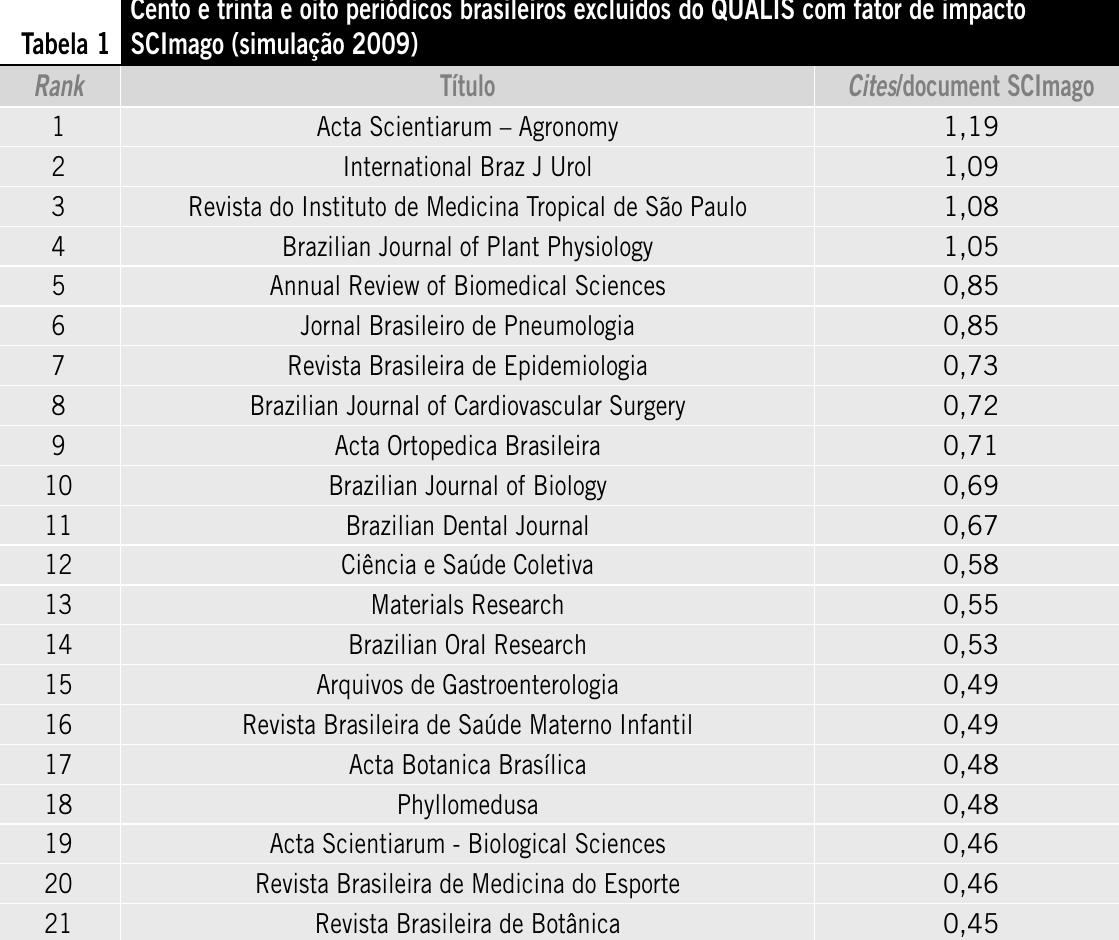
Fator de impacto Figura 1 – Correlação entre os fatores de impacto ISI-Thomson e SCImago (2009) para 64 periódicos brasileiros re- presentados nos dois índices com valores maiores que zero. A identidade entre métricas é praticamente absoluta. O coeficiente angular indica ângulo de 45 o (significando identidade) e a correlação (R = 0,932; p < 0,001) é quase perfeita